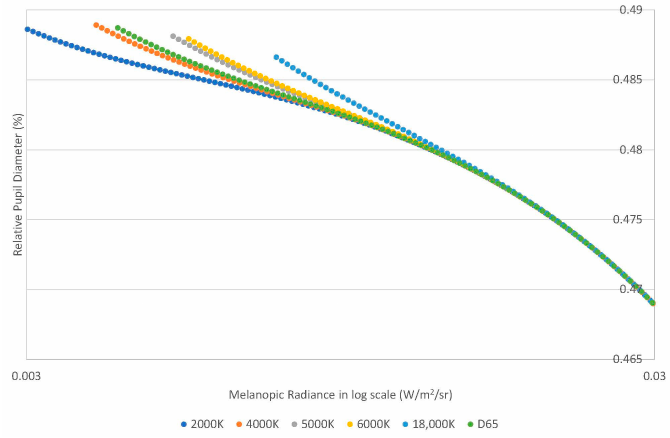
Figure 12. Calculated Steady-State of Pupil Diameter with Formula (6) vs. Melanopic Radiance of Stimulus (log scale).